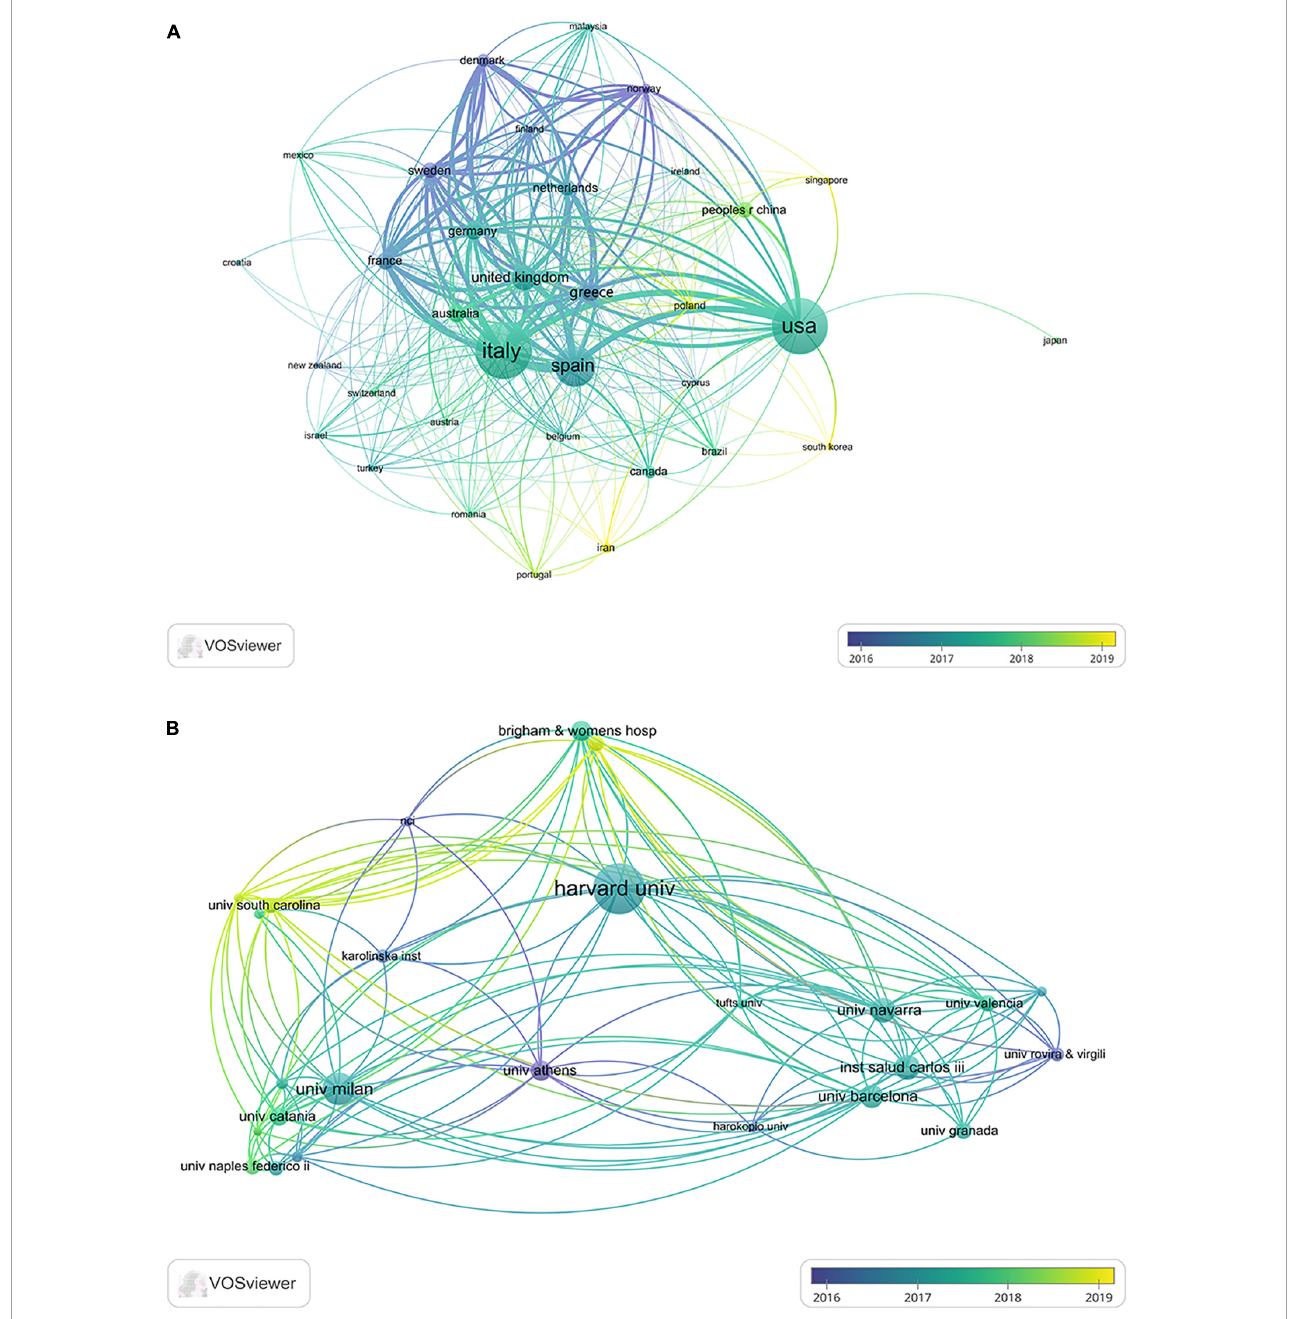
FIGURE4 The co-authorship network diagram of panel (A) the countries/regions and (B) institutions. The size of the nodes represents the number of publications, the lines represent cooperation, and the color of the nodes represents the